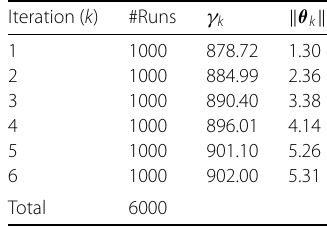
Table 6 Memory cell: HISMC exploration phase Iteration ( k ) #Runs γ k (cid:21) θ k (cid:21) d r LOO-MCR (%) 1 500 883.38 1.91 35 2.0 2 350 892.40 3.64 34 1.0 3 340 901.75 5.30 33 1.0 4 330 902.00 5.32 33 1.0 Total